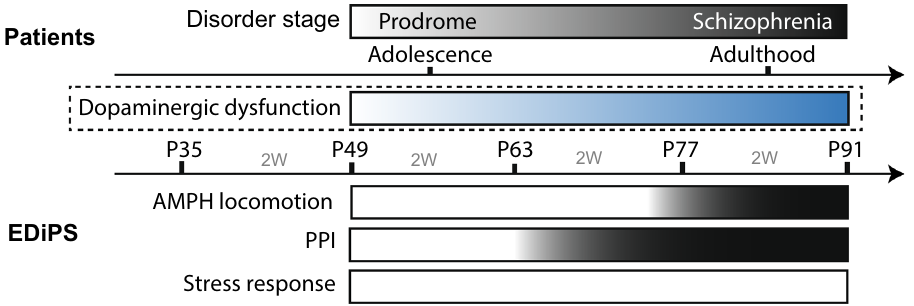
Figure 5. Summary of findings. In EDiPS animals, the increase in AMPH-induced hyperlocomotion is evident from 6 weeks following administration of the EDiPS construct at P35. In contrast, the PPI deficit is apparent from 4 weeks following administration of the construct. No difference in the response to stress is seen over this time. This progression of behavioural phenotypes likely reflects an increasing dysfunction of dopaminergic activity in the dorsal striatum, induced by the EDiPS construct. This parallels the increase in dopaminergic dysfunction which appears to contribute to the transition in patients from the prodromal stage of schizophrenia to expression of the full